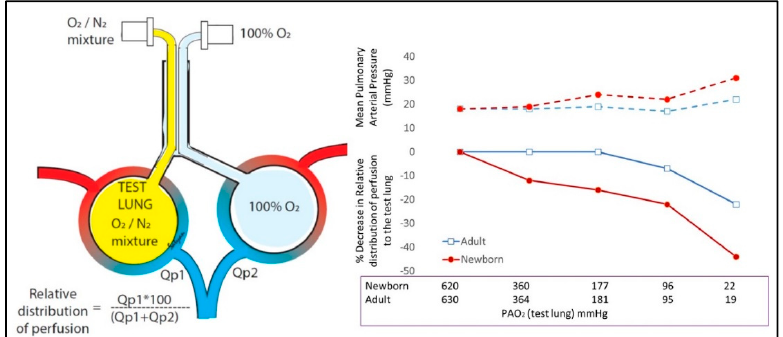
Figure 2. Created using data from Custer et al. [31]. Importance of alveolar hypoxia in directing lung blood flow. Neonatal lambs and adult sheep were instrumented. Each lung was intubated with a different endotracheal tube. One lung was ventilated with 100% oxygen and the other test lung with varying concentrations of oxygen mixed with nitrogen. Relative distribution of perfusion was calculated with Qp1 (blood flow to test lung) and Qp2 (blood flow to the 100% oxygen lung) using the formula shown in the figure. Lower PAO 2 had a profound effect on pulmonary vasoconstriction in newborn ovine model (red line) compared to adults (blue line). Table 1. Effect of PAO 2 on control and PPHN ovine models on PVR [12]